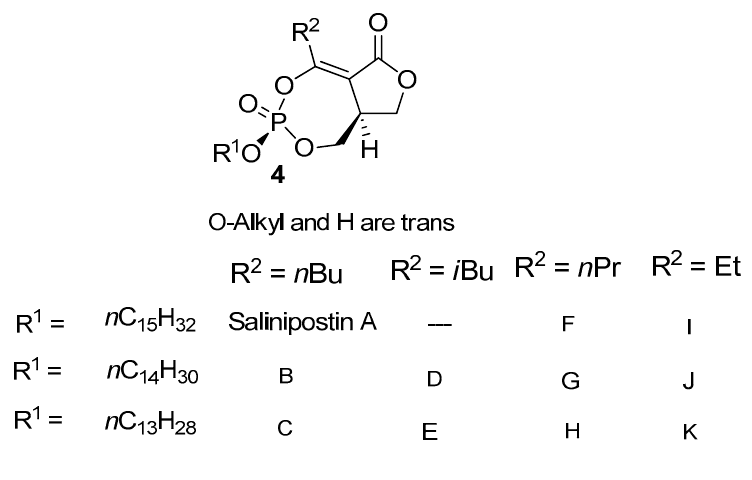
Figure 3. The salinipostins.